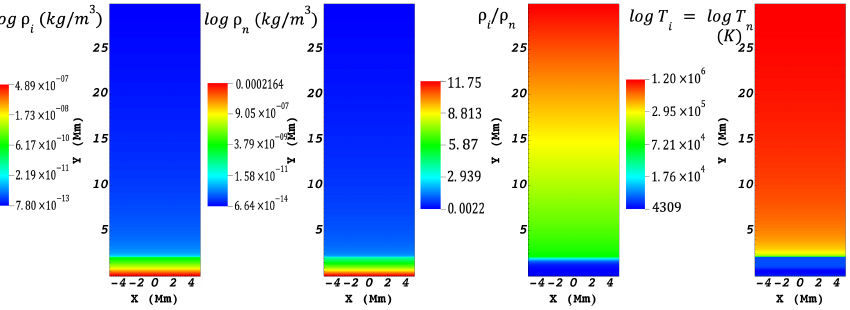
Figure 1. Left to right : The log ρ i , log ρ n , ion-to-neutral densities ratio, ρ i / ρ n , for the solar atmo- sphere model at the initial time, t = 0, and log T i = log T n